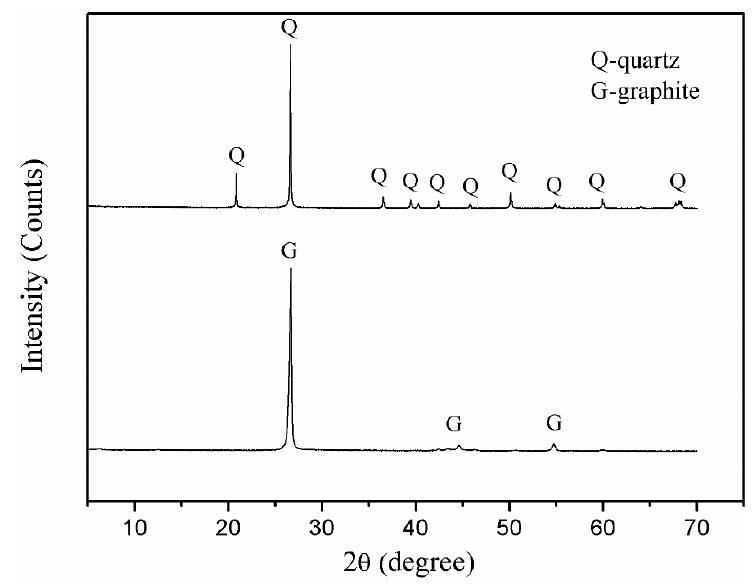
Table 3. Chemical analysis of microcrystalline graphite and quartz minerals.